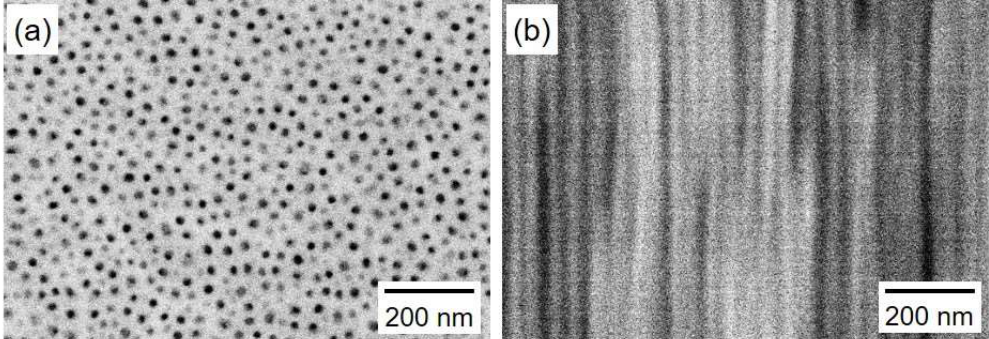
Figure 3. Planar-view ( a ) and cross-sectional ( b ) SEM images of anodized aluminum oxide nanochannel templates that were anodized at 20 V for 24 h. The electrolytic solution temperature was kept at 2 ◦ C during the anodization.